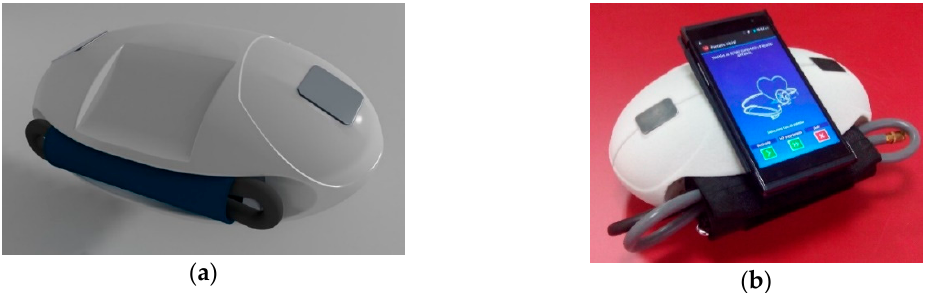
Figure 4. CAD prototype designed ( a ) and final 3D printed prototype assembled ( b